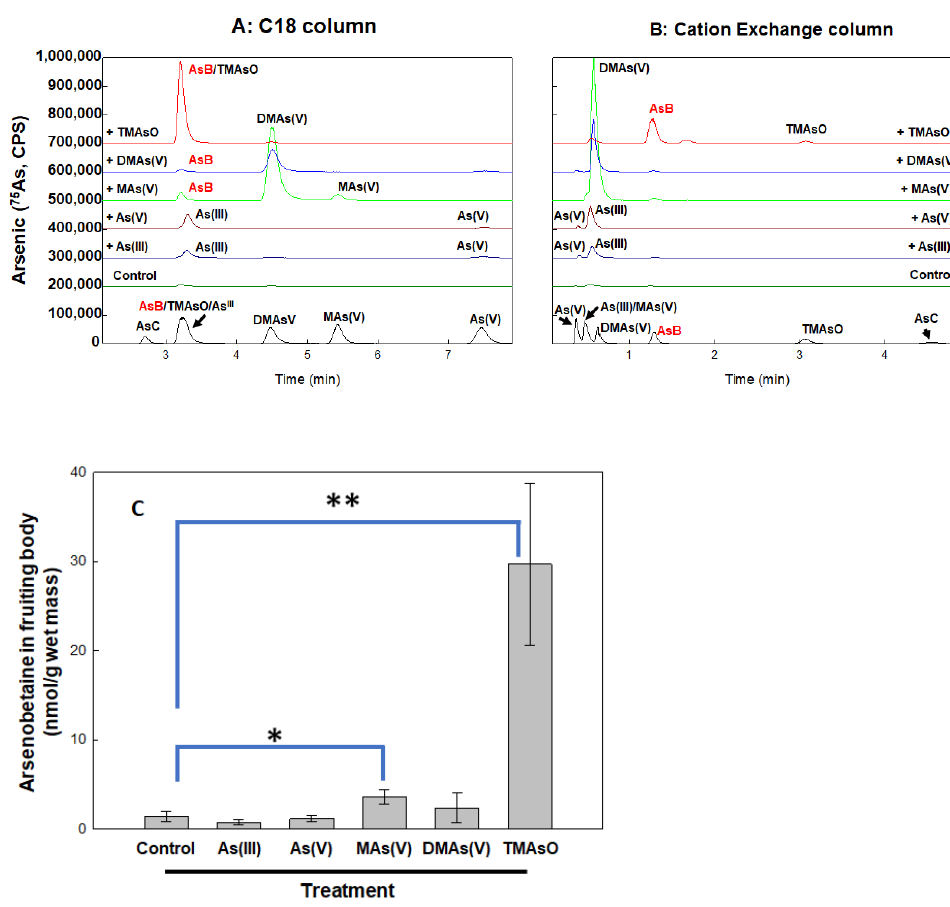
Figure 3. Metabolism of various arsenic compounds in A. biosporus . Various arsenic substrates were added to compost and allow for fruiting. In the fruiting body, arsenic species were determined by HPLC-ICP-MS using two different types of HPLC: C18 column ( A ) and cation exchange column ( B ) One representative data out of the three replicates is shown. AsB content under various treatment is quantified and compared ( C ) Four replicates were collected for each sample ( N = 4). The values of AsB were calculated by the peak area (* p < 0.05 and ** p < 0.01).